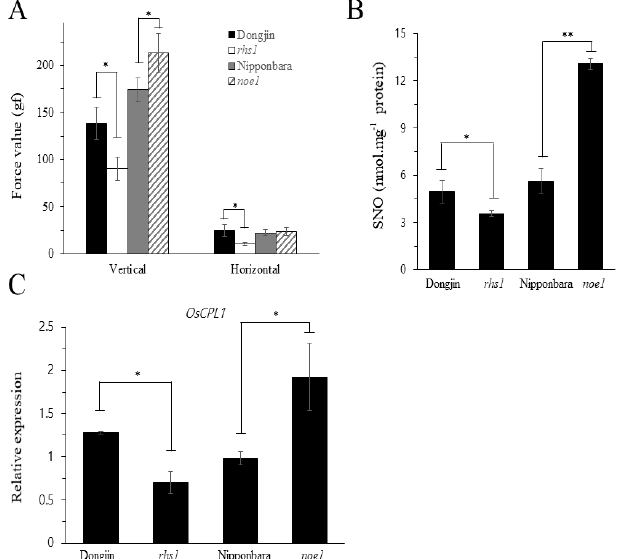
Figure 3. RHS1 regulates seed shattering and SNO contents in rice. The seeds of rhs1 plants showed a significantly lower force value in terms of the vertical and horizontal force required to pluck them from the base of the spikelet ( A ). The endogenous level of SNO was significantly lower in the rhs1 plants compared to the WT, and a high SNO-containing mutant ( noe1 ) exhibited higher SNO levels ( B ). The expression of rice CPL1 , the negative regulator of seed shattering, is shown ( C ). Each data point represents the average of three data points. Means were analyzed for significant difference using the Student’s t -test. Error bars represent the standard deviation. Significant differences are represented by an asterisk (*) at p < 0.05, (**) p <